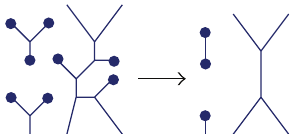
Figure 3: An example of tree